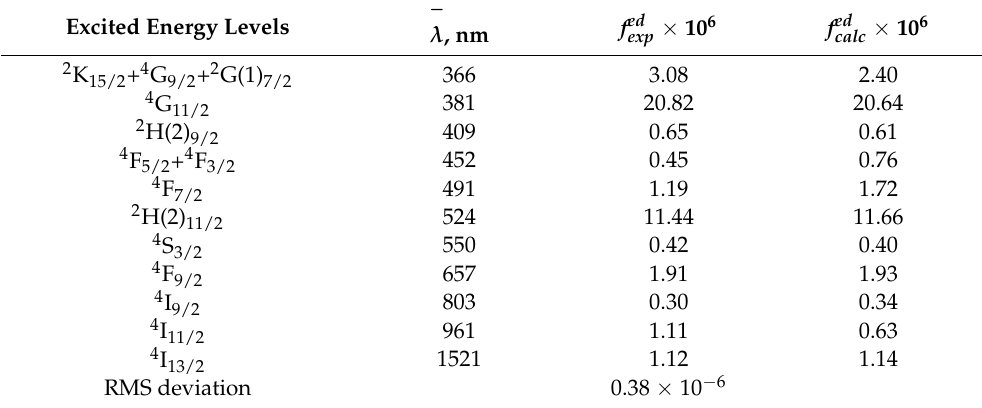
) oscillator strengths of Er 3+ in Y 2 O 3 . calc